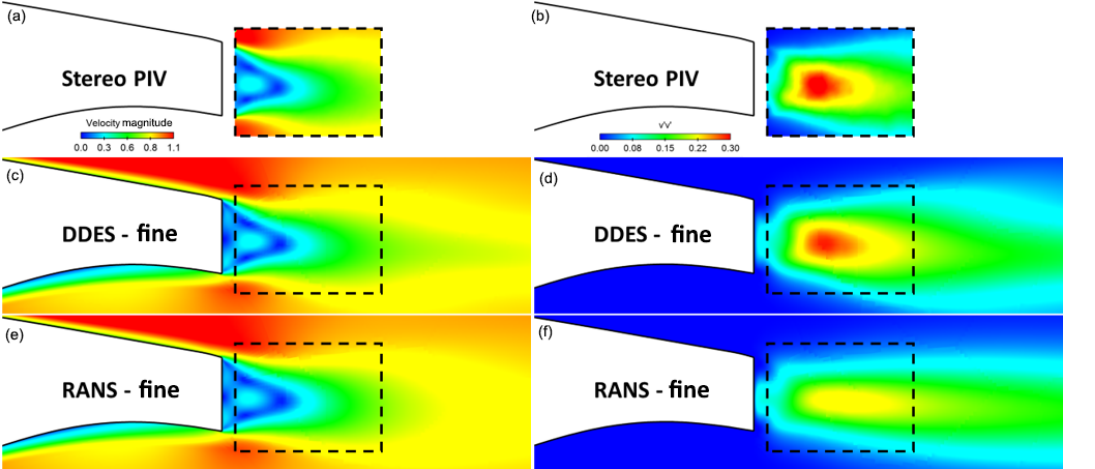
Figure 8. Plain airfoil case. Normalised velocity magnitude contours, V/V ∞ , (a, c, e) and v (cid:48) v (cid:48) /V 2 ∞ normal Reynolds stress contours (b, d, f) : comparison between stereo PIV, RANS and IDDES results. The fine mesh (25 million cells) was used in the